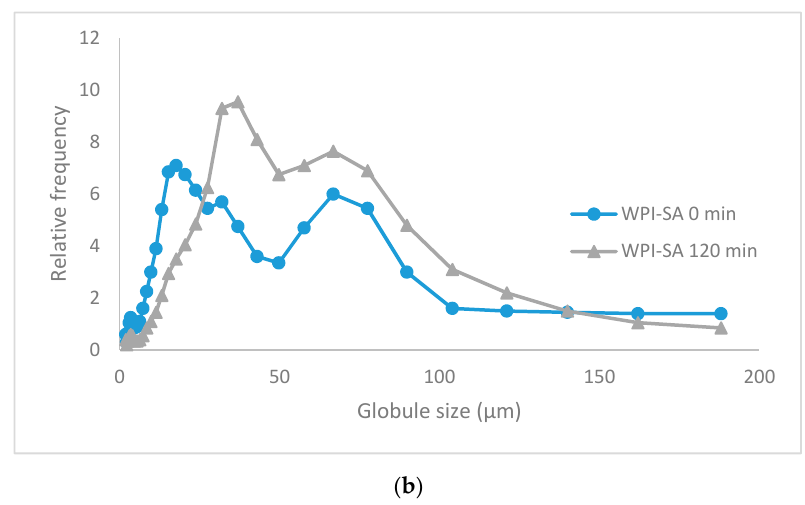
Figure 4 . Particle size distribution of coacervated microcapsules with ( a ) WPI–CMC and ( b ) WPI–SA systems, at the beginning (0 min) and end (120 min) of gastric digestion (7.0 pH).